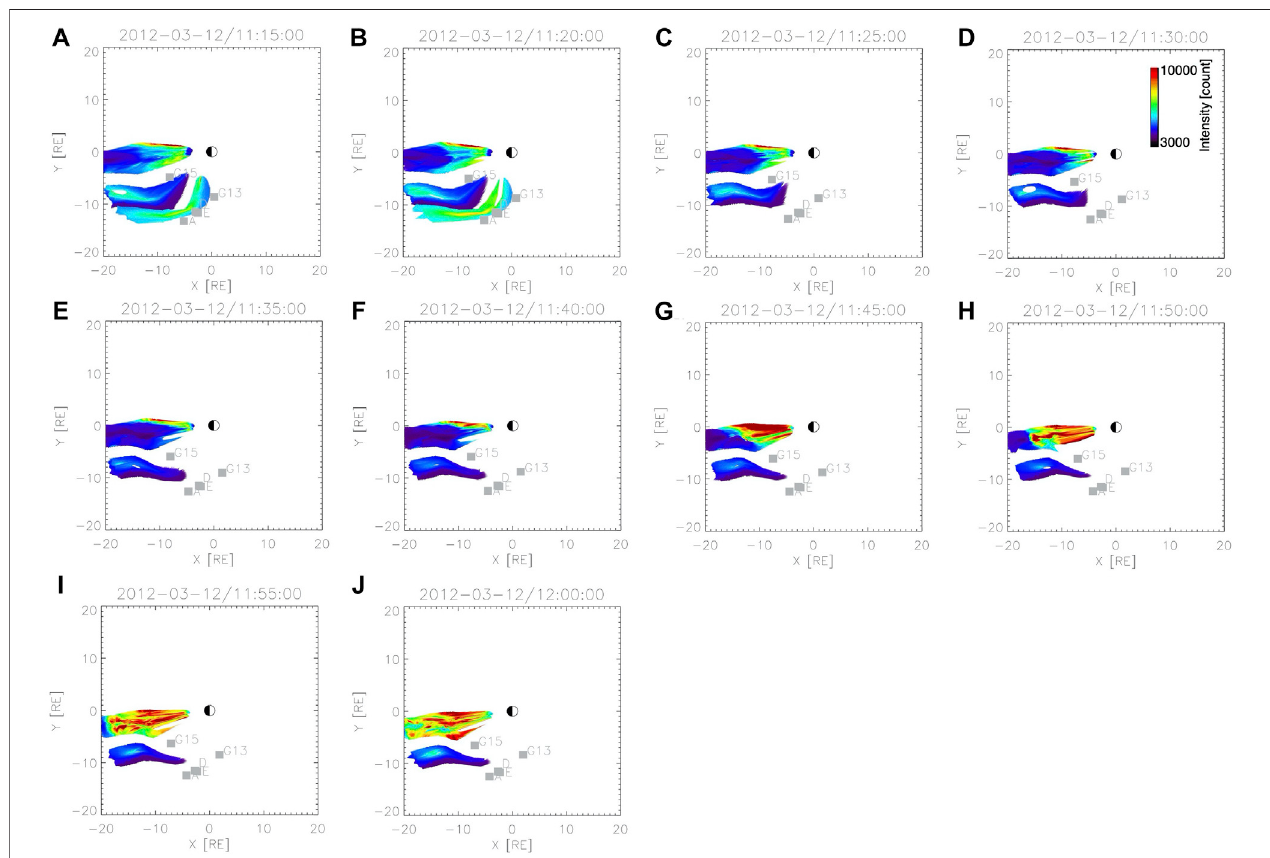
FIGURE 5 | THEMIS ASI auroral images mapped to the GSM equatorial plane using TS01 for 9:15 – 12:00 UT. The colorbar in panel (D) applies to all panels. Symbols indicate the mapped location of the GOES 13 (G13), GOES 15 (G15), and THEMIS (A, D, E) satellites.